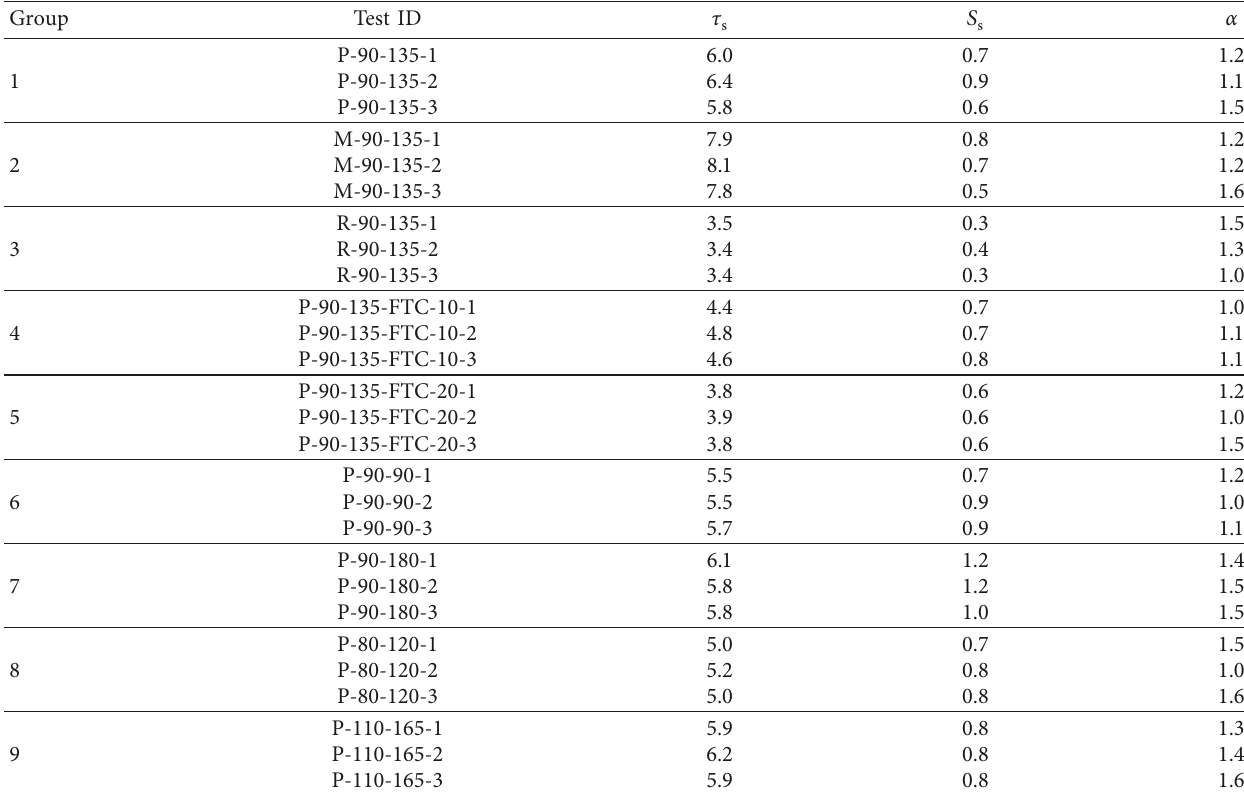
Figure 13: Critical displacement comparison. Table 5: α values of different